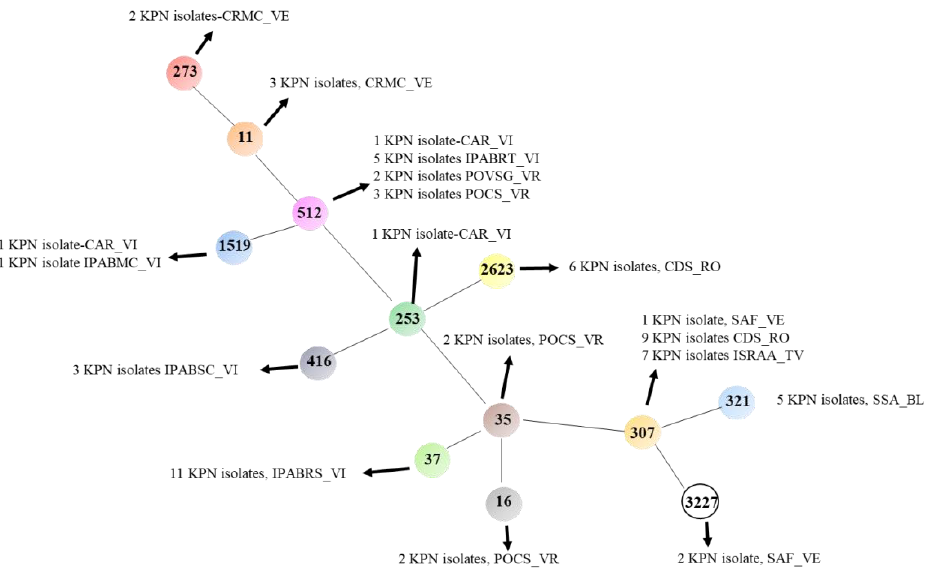
Figure 1. Phylogenetic tree of K. pneumoniae strains selected for MLST. The minimum spanning tree was obtained using PHYLOViZ online software (http://www.phyloviz.net/). For legal aspects, we used only the acronym of the twelve LTCFs. Table 2. Genome analysis of K. pneumoniae isolated from residents of twelve LTCFs (Northern Italy).